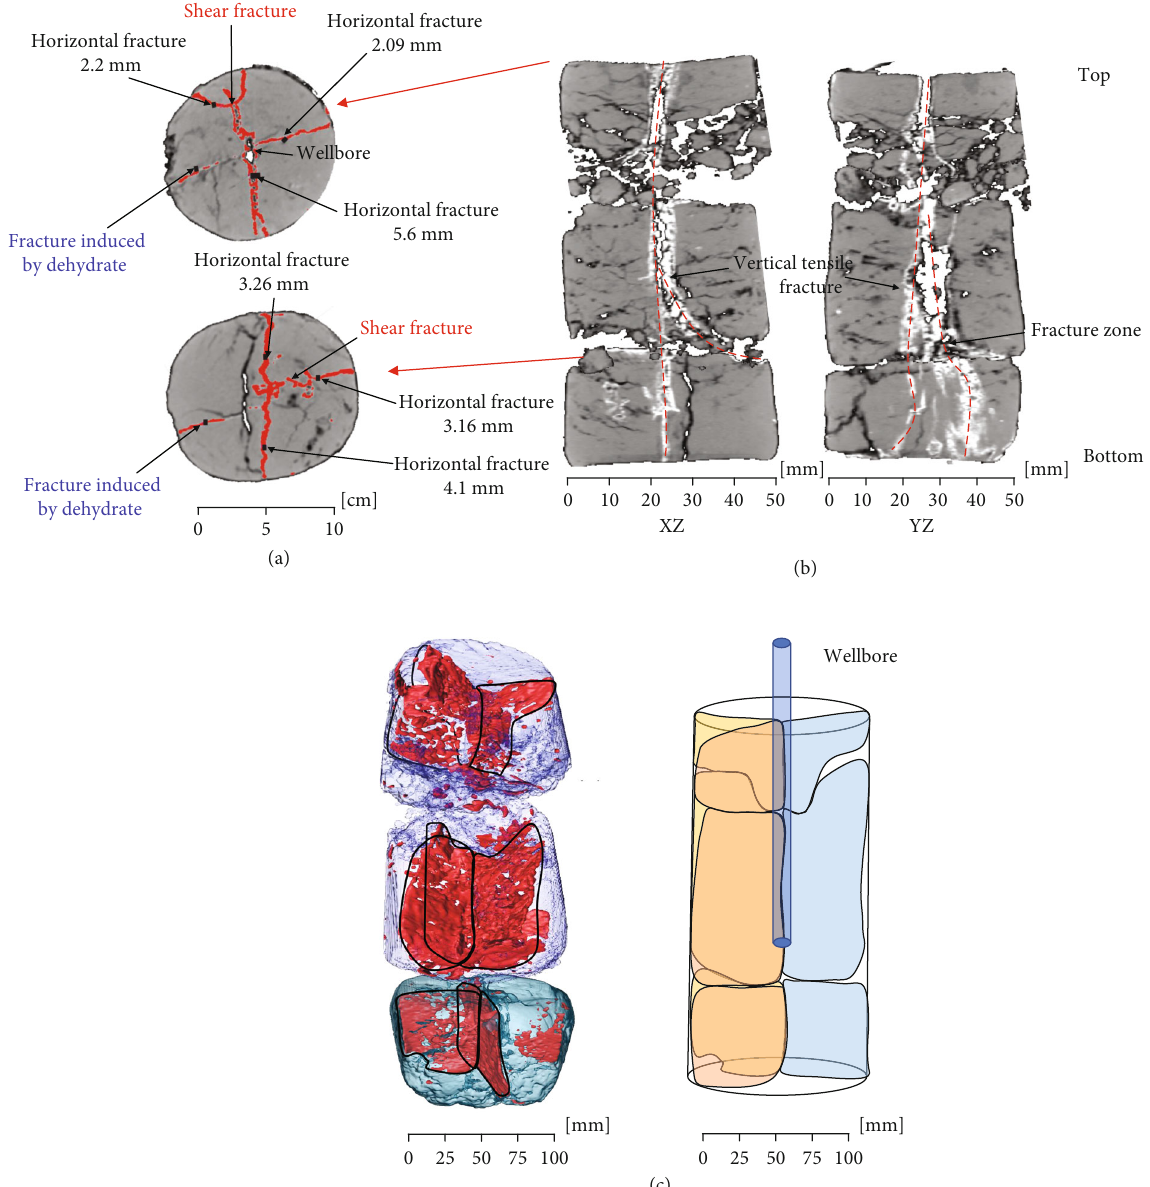
Figure 9: The fracture characteristics of sample 2 after hydraulic fracturing by CT: (a) CT section image, (b) CT perspective views, and (c) 3D